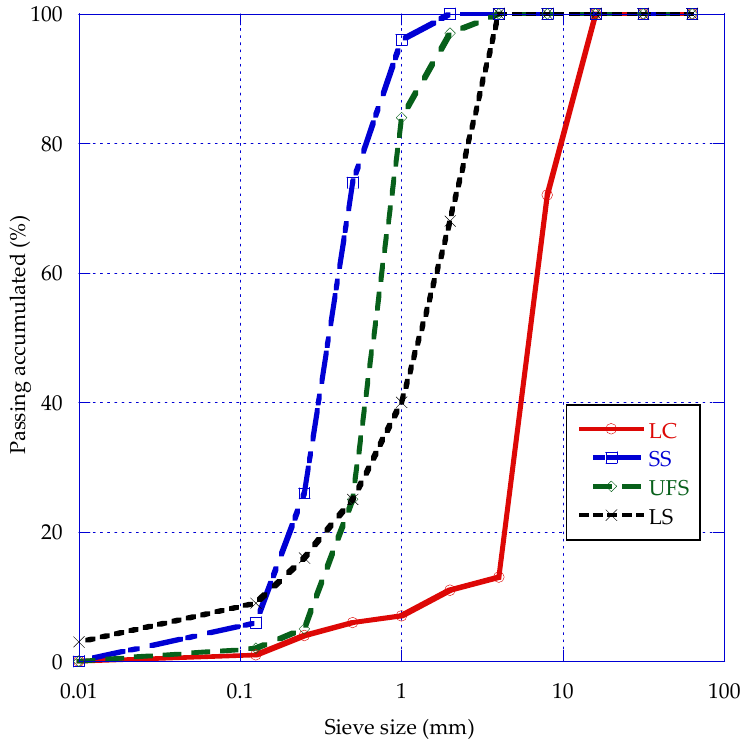
Figure 1. Grading curves of the aggregates.